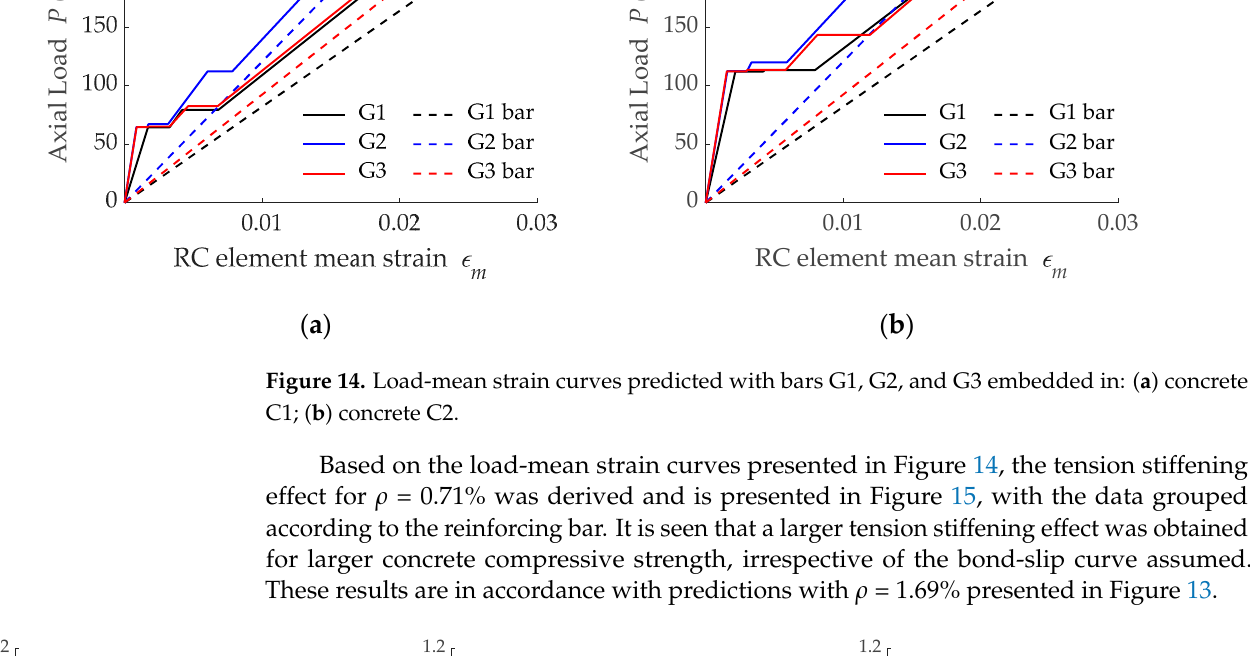
Figure 14. Load-mean strain curves predicted with bars G1, G2, and G3 embedded in: ( a ) concrete C1; ( b ) concrete C2.